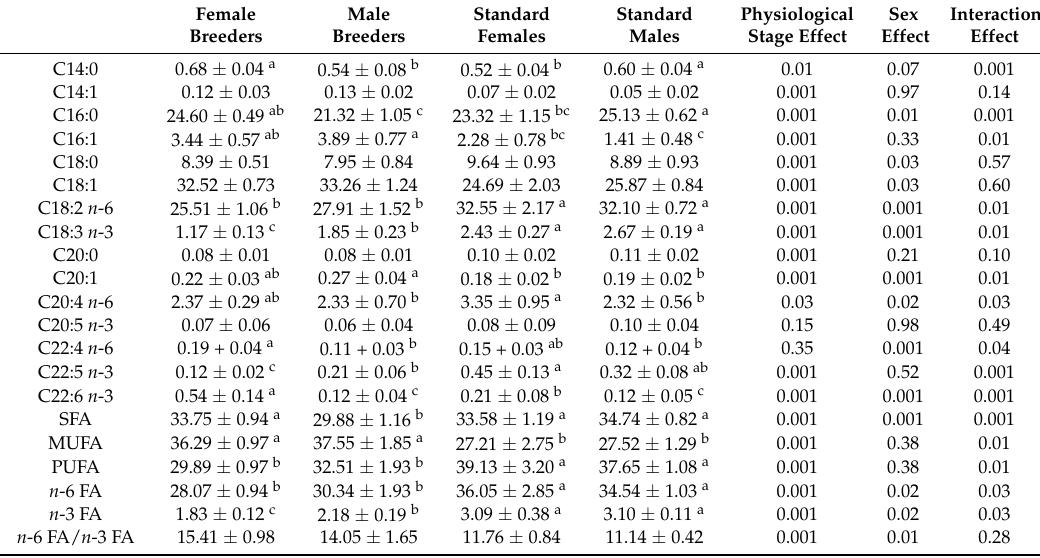
Table 5. Fatty acid (FA) composition of I. superficialis muscle from males and females of breeder and standard turkeys (% total FA, n =